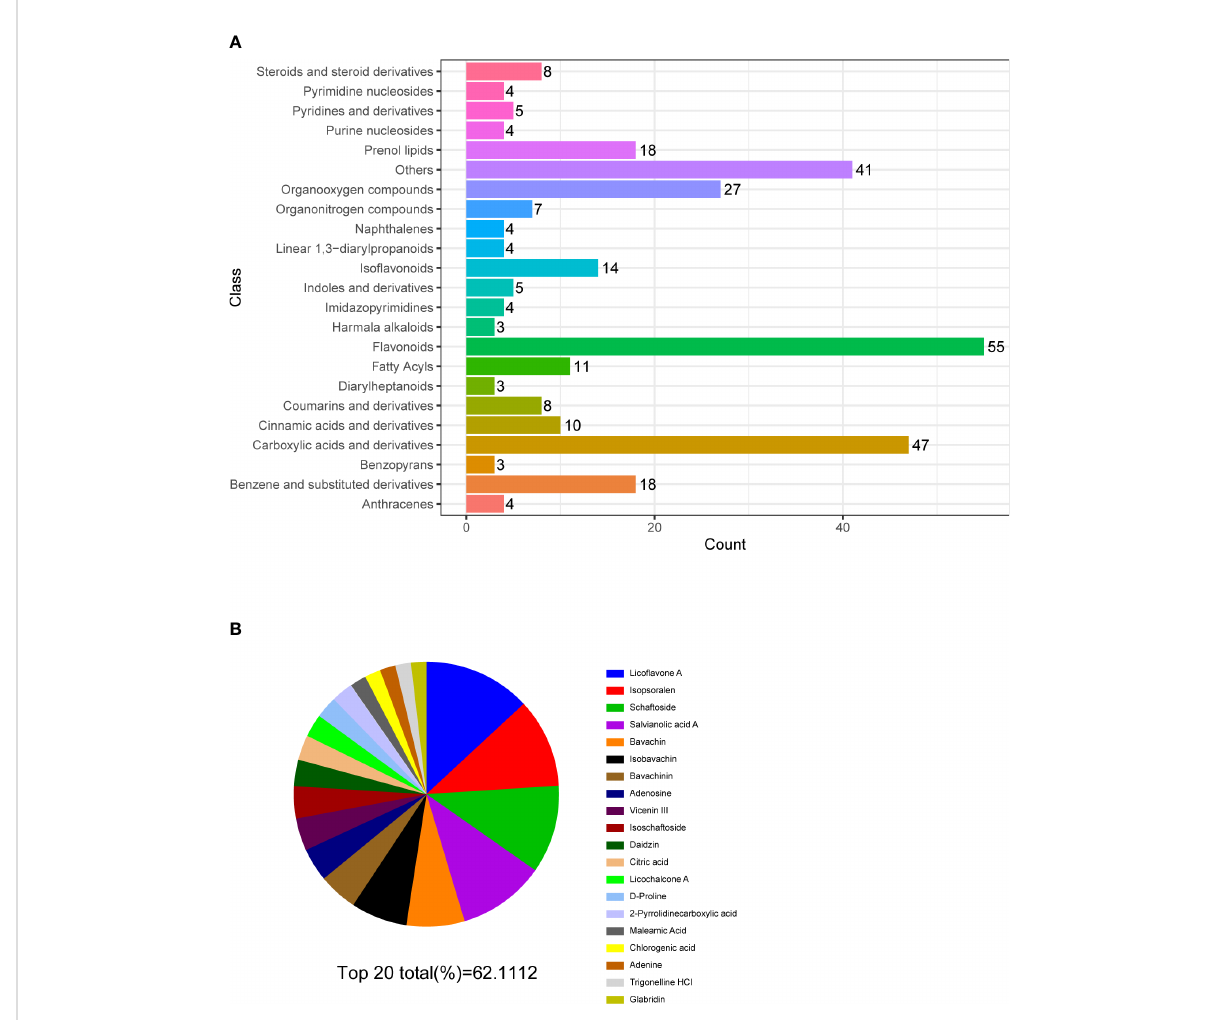
FIGURE 5 Multiple reaction monitoring. (A) Classi fi cation and functional annotation of metabolites identi fi ed by LC/MS of MQEF aqueous decoction extract. (B) The top 20 small molecules in terms of relative percentage of each metabolite component calculated by the peak area normalization